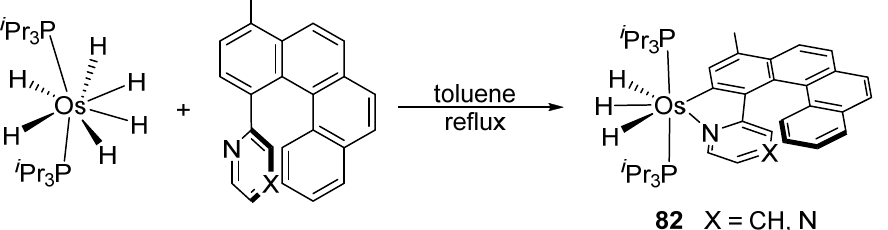
Figure 16. Cyclometalation via by C–H activation assisted by reductive elimination of hydride ligands.